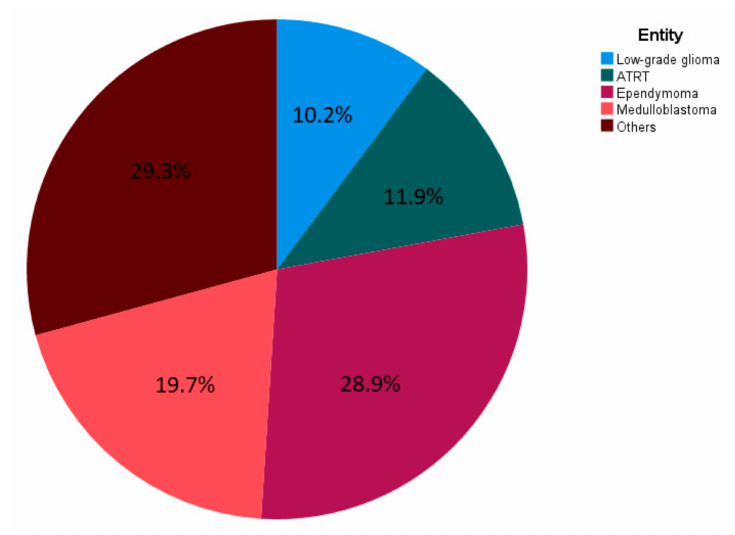
Figure 1. Entities of CNS tumors among included patients.